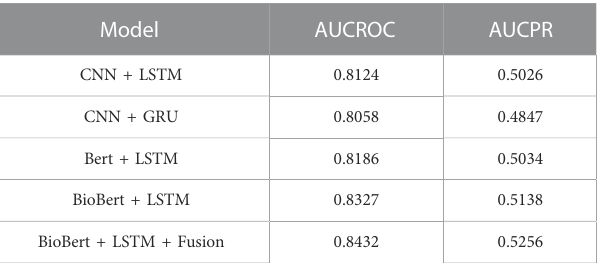
TABLE 4 Performance of each model in the 7 clinical record.